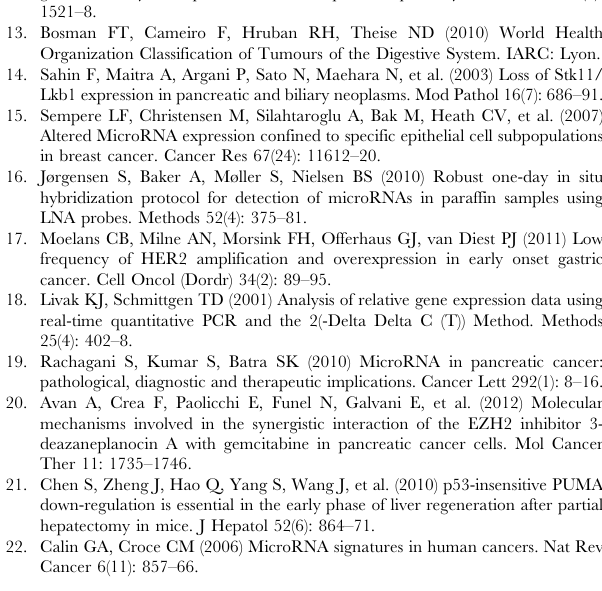
Figure S1 Scatter chart of the correlation analysis of miR-26a vs. cyclin E2 expression and the miR-26a vs. PCNA expression. Table S1 Nucleotide sequences in research. Table S2 Antibodies used in immunostaining